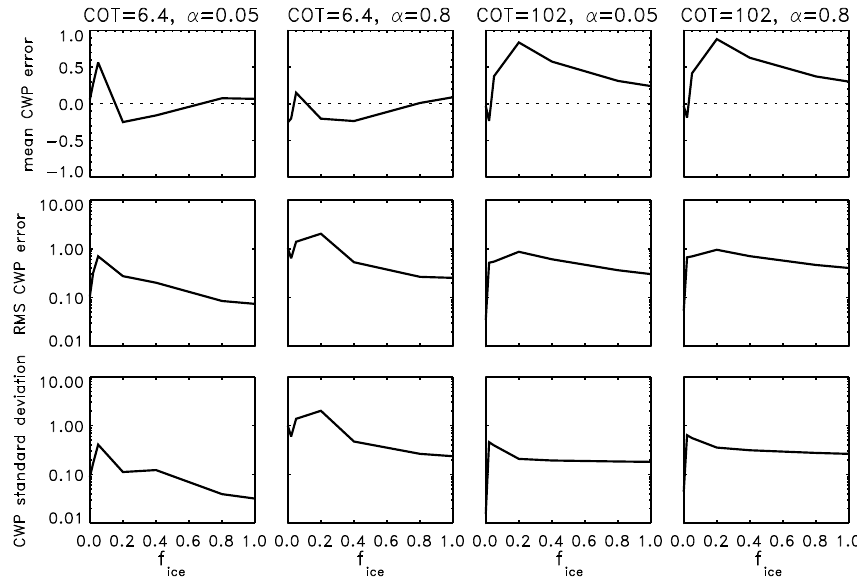
Fig. 6. As Fig. 4, except the errors are shown as functions of f ice for several combinations of COT and α surf . to a different CPP LUT, shows as a sign change in the mean error. The CWP errors in that regime are mainly caused by the mismatch between retrieved and bulk cloud values of r eff